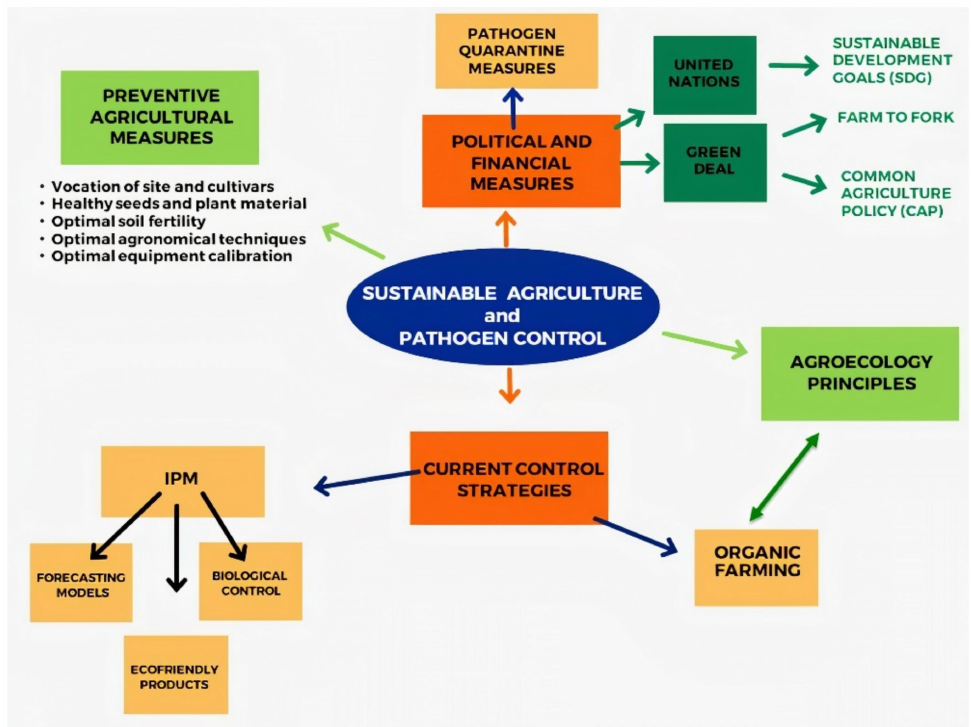
Figure 1. Synoptic panel that shows the current strategies and policies related to the achievement of sustainable disease control in